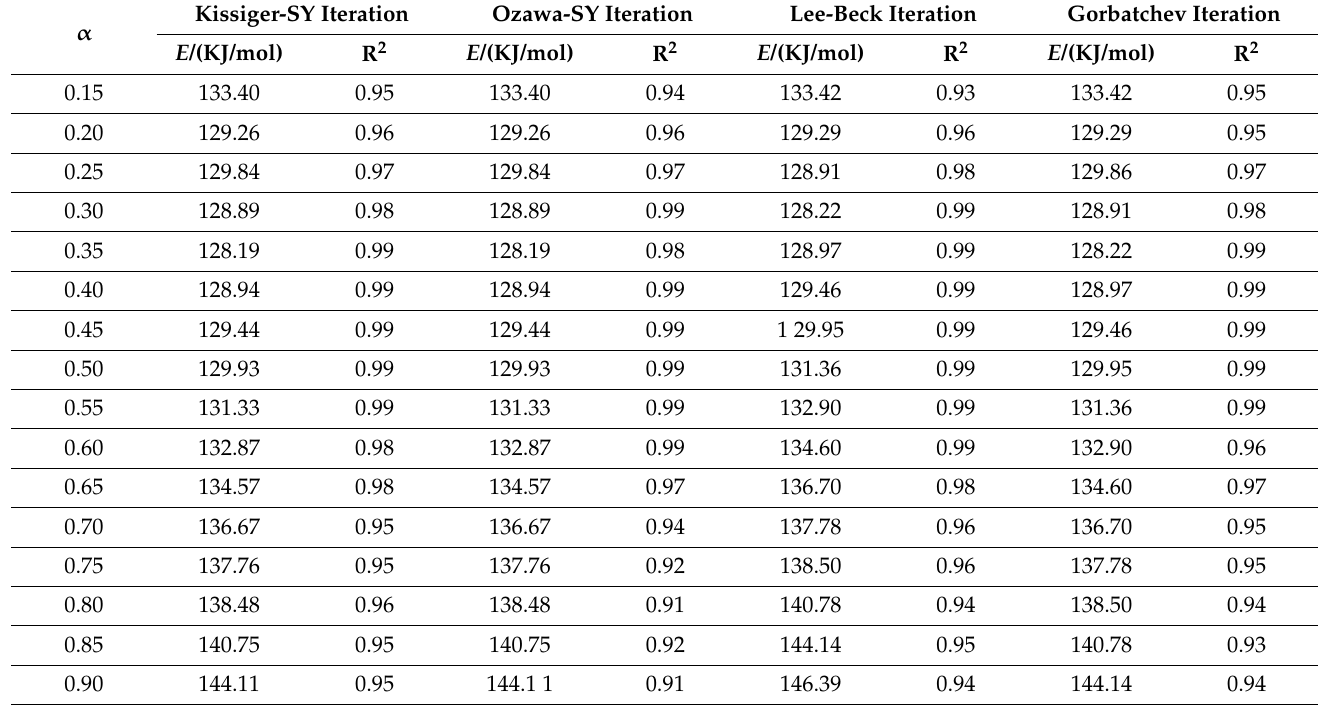
Table 3. Activation energy of EP/15% F-Lignin@HKUST-1 at different